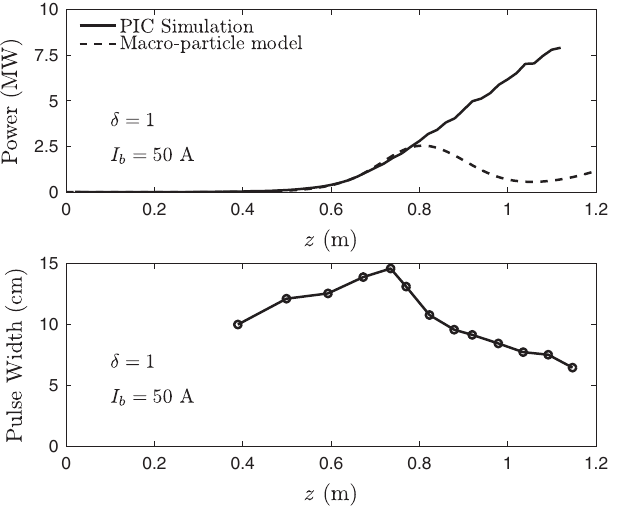
FIG. 26. Growth rate of the radiation pulse in the superradiant